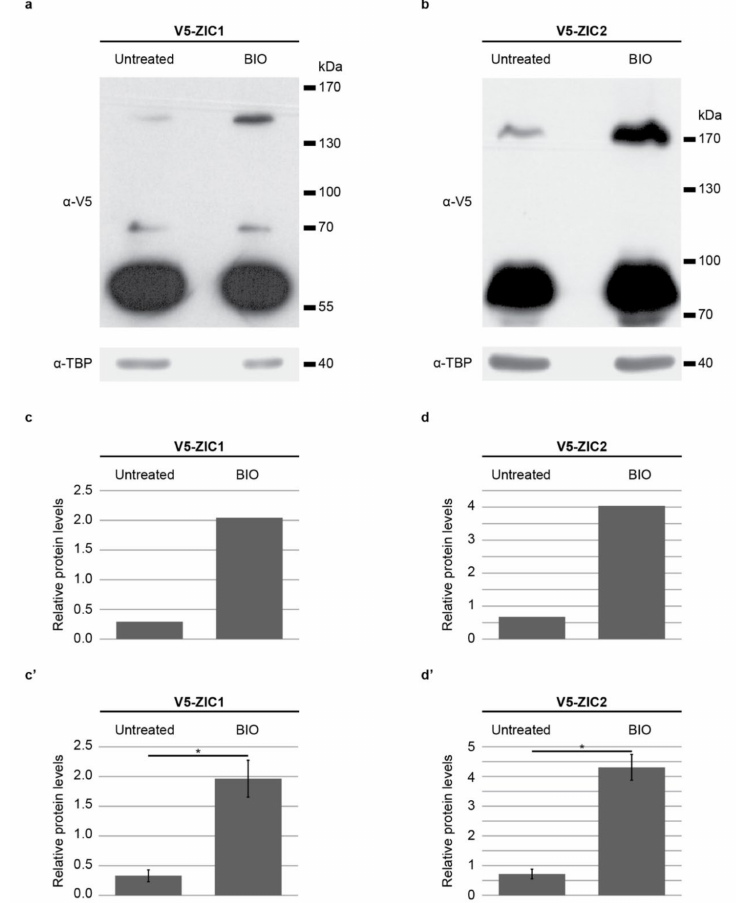
Figure 6. Activation of the canonical WNT pathway promotes ZIC SUMOylation. ( a – d ’) Quantification of SUMOylated ZIC based on WB analysis of ZIC protein in the nuclear fraction of HEK293T cells co-transfected with V5 epitope-tagged ZIC expression plasmids and EmGFP-SUMO1-WT followed by incubation in the presence or absence of the GSK inhibitor (2 (cid:48) Z,3 (cid:48) E)-6-Bromoindirubin-3 (cid:48) -oxime (BIO). ( a , b ) Representative WBs for the ZIC1 or ZIC2 analysis. For WB of nuclear fractions (using antibody against V5), antibody against TBP was used as a loading control. ( c , d ) Quantification of the SUMOylated ZIC protein in the presence or absence of BIO in the WB shown in ( a , b ), respectively. ZIC1 and ZIC2 protein levels were quantified relative to TBP using ImageJ. ( c ’, d ’) Average level of SUMOylated ZIC protein from five independent experiments. For both ZIC1 and ZIC2, incubation with BIO significantly increases the amount of the SUMOylated form of ZIC. *: p < 0.01 two-sample t -test. Error bars denote ±